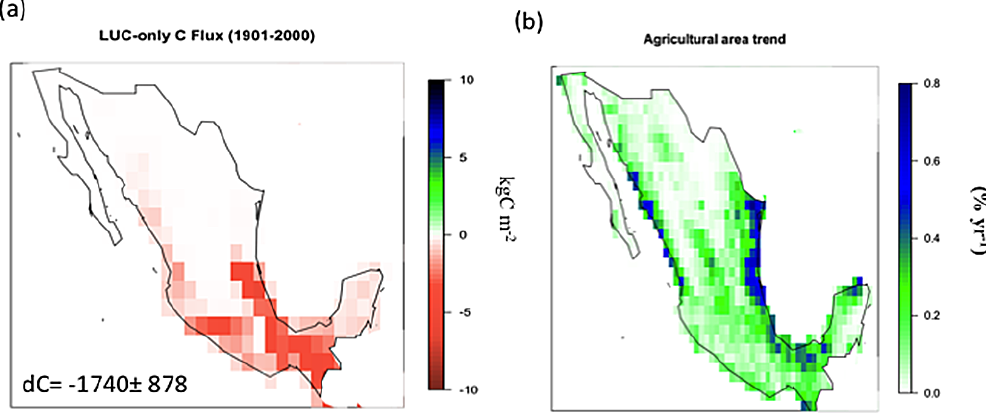
Figure 9. (a) Change in stored C by the effect of LULCC only for the period 1901–2000 (kgCm − 2 ) . A positive sign indicates C gain. dC is total change in stored C (TgC). (b) Agricultural area change for the same time